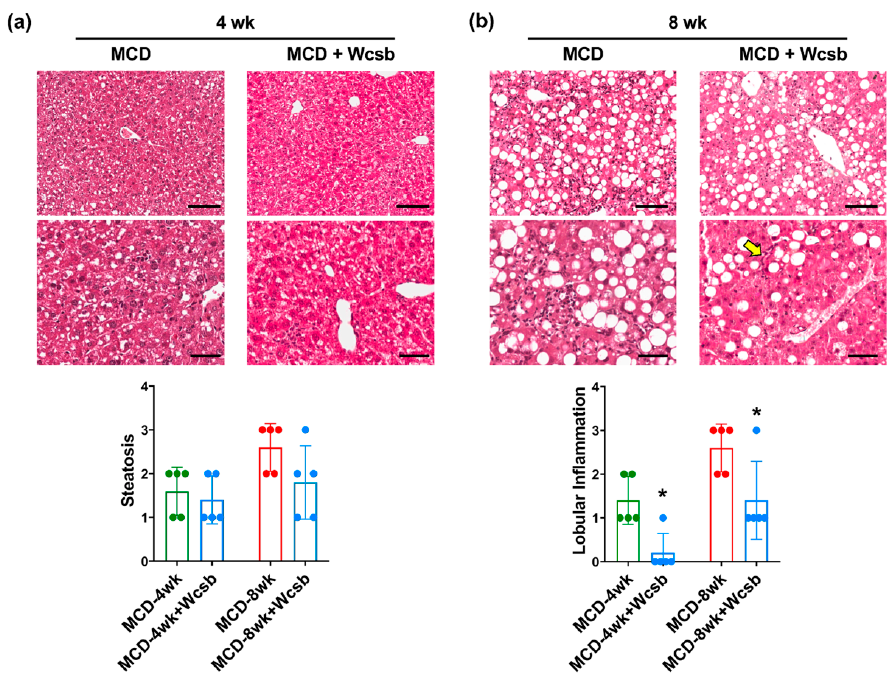
Figure 2. Histopathological changes in mice subjected to a methionine-choline-deficient (MCD) diet and treated with calcium-sulphate-bicarbonate water (W csb ). ( a , b ) . Hematoxylin and eosin (H&E) stain on mouse livers after four weeks (4wk, ( a )) or eight weeks (8wk, ( b )) of MCD diet administration with or without W csb . In MCD mice, no significant difference was observed in terms of liver steatosis (upper panels) after W csb administration. Lobular inflammation (lower panels, arrows) was reduced after W csb administration compared to untreated MCD mice. Scale bars: 100 µ m ( upper panels ) and 50 µ m ( lower panels ). Histograms show means and standard deviations for steatosis and inflammation scores. Data from each animal are plotted as solid circles in the graph. * p < 0.05 vs. MCD.